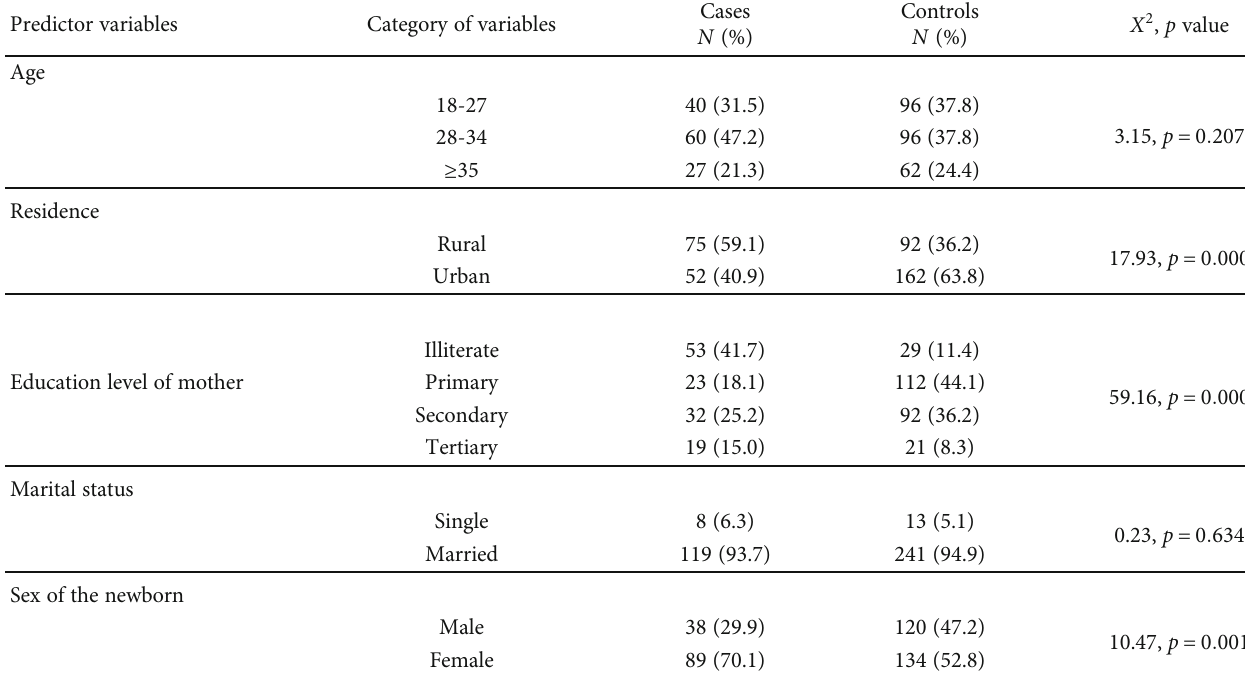
Table 1: Sociodemographic characteristics of participants who gave birth at public referral hospitals, Amhara Region, Ethiopia, 2019. Predictor